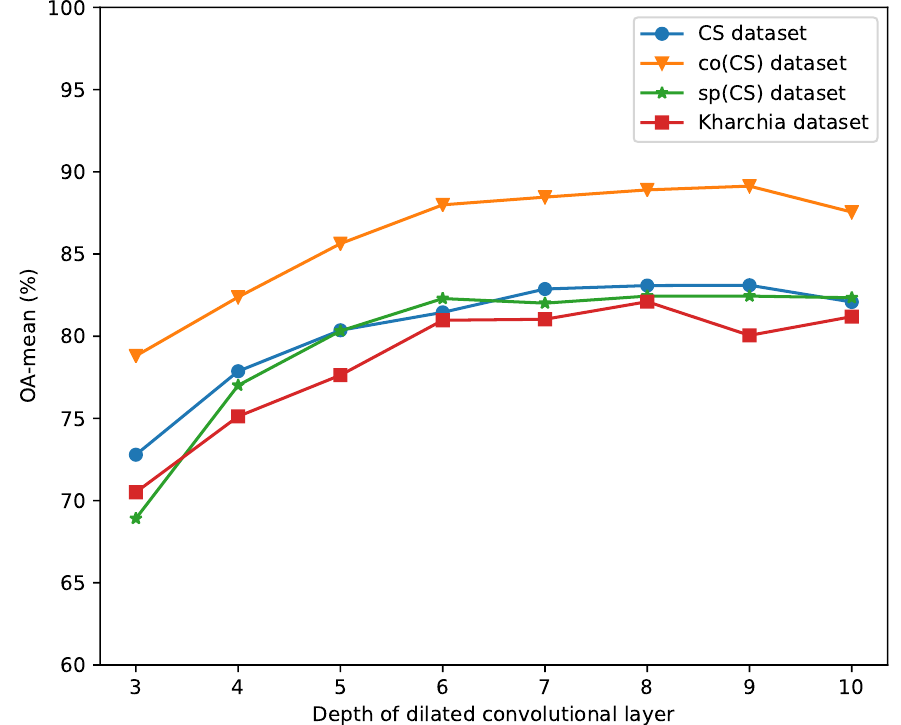
Figure 5. Performance comparison of our proposed method for different numbers of dilated convolu- tional layers. OA-mean is the average of OA from 5-fold